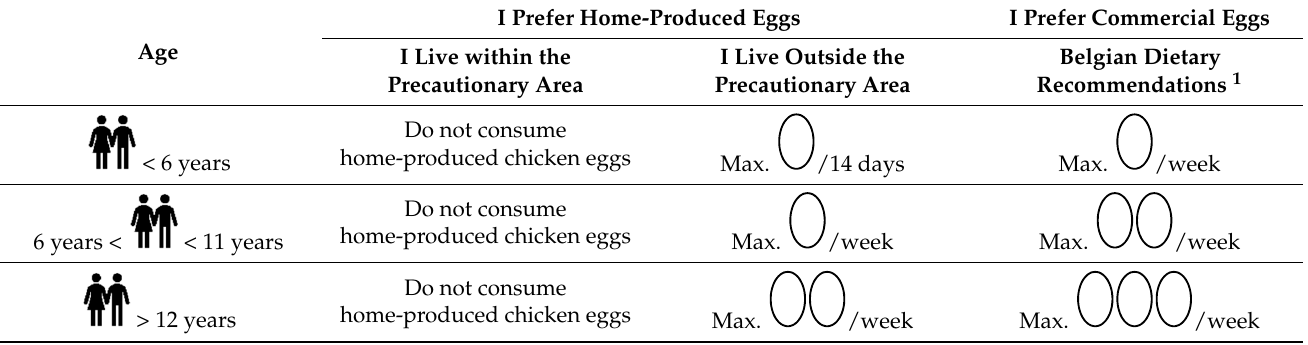
Table 5. Calculated values for safe consumption of home-produced eggs, with corresponding dietary recommendations and number of measurement locations in each category.